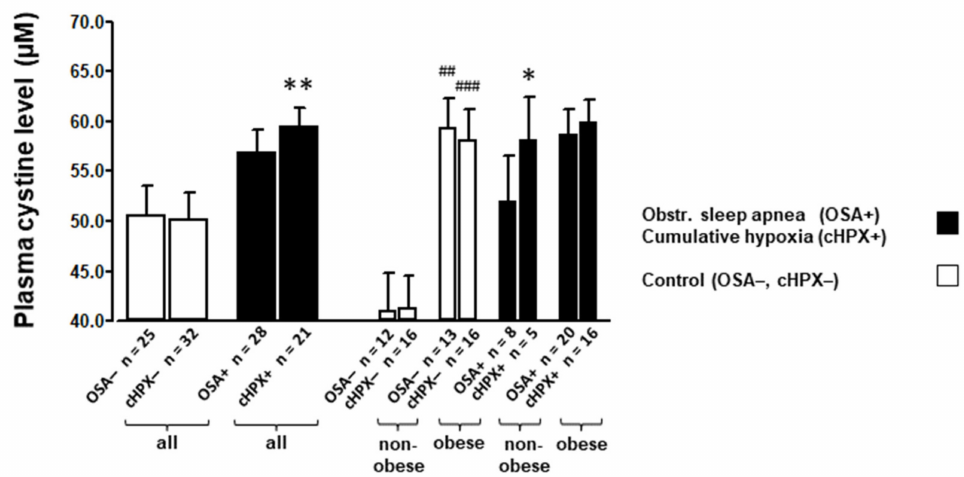
Figure 2. Mean ( ± SEM) plasma cystine (CySS) levels of OSA patients (AHI > 15 h − 1 ) or the explorative group with cumulative hypoxic stress (cHPX, defined as time at O 2 -saturation < 90% > 15.2 min) compared to their respective controls group with stratification for non-obese and obese BMI. According to a two-factorial ANOVA, both cHPX and OBS significantly and independently impacted plasma CySS levels (see also Tables 1 and 2). * for p < 0.05, ** p < 0.01 for significant differences between OSA patients or the cHPX group (total group or strata) and their respective control (strata); ## for p < 0.01, ### for p < 0.001 for significant differences between obese and non-obese controls as detected by unpaired t